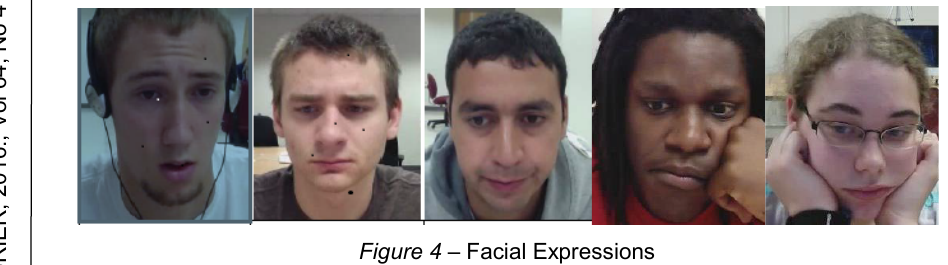
Рис . 4 – Выражение эмоций на лице Slika 4 – Facijalne ekspresije